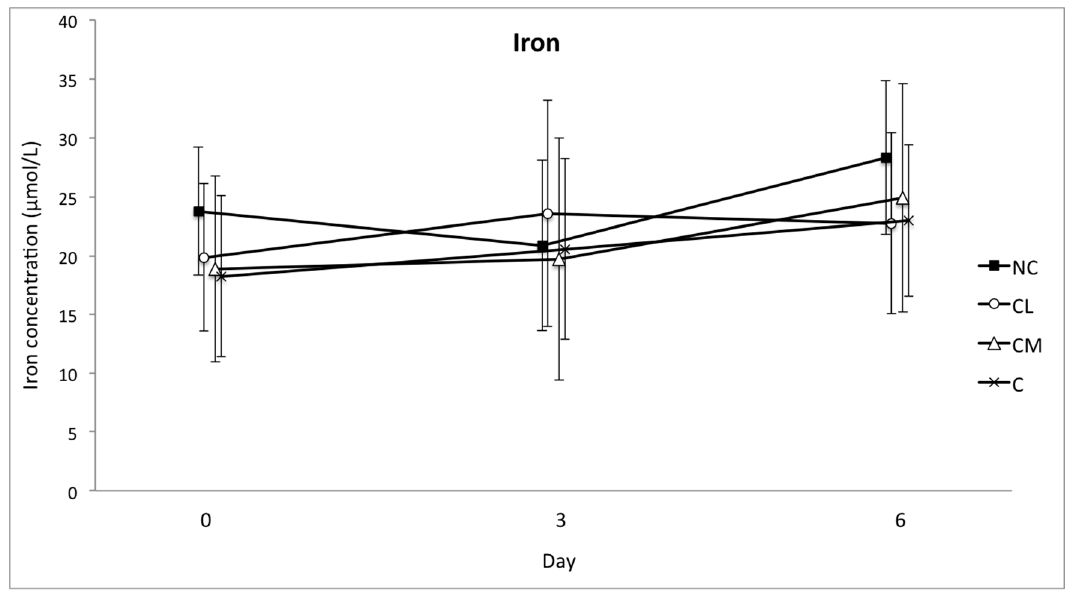
Figure 7. Mean ( ± SD) concentration of iron in serum ( µ mol/L) of Bos indicus bull calves before and after surgical castration. NC = no castration, CL = castration with lidocaine, CM = castration with meloxicam, C = castration without analgesia.